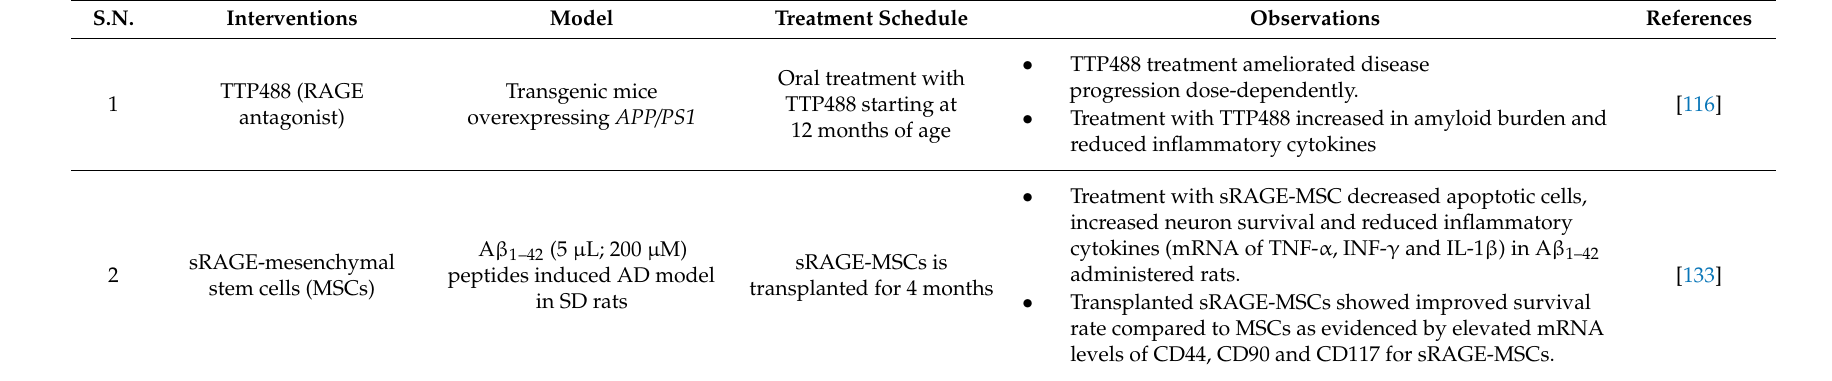
Table 2. Summaries of studies reporting RAGE inhibition in AD and related